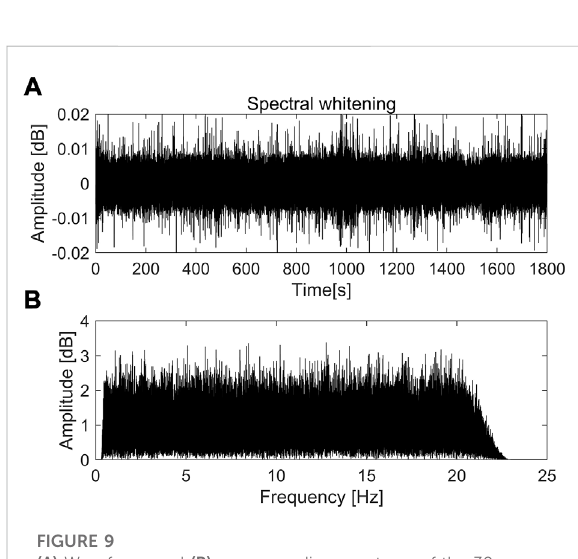
FIGURE 9 (A) Waveform, and (B) corresponding spectrum of the 30- min record of Channel 200 in Line II after spectral